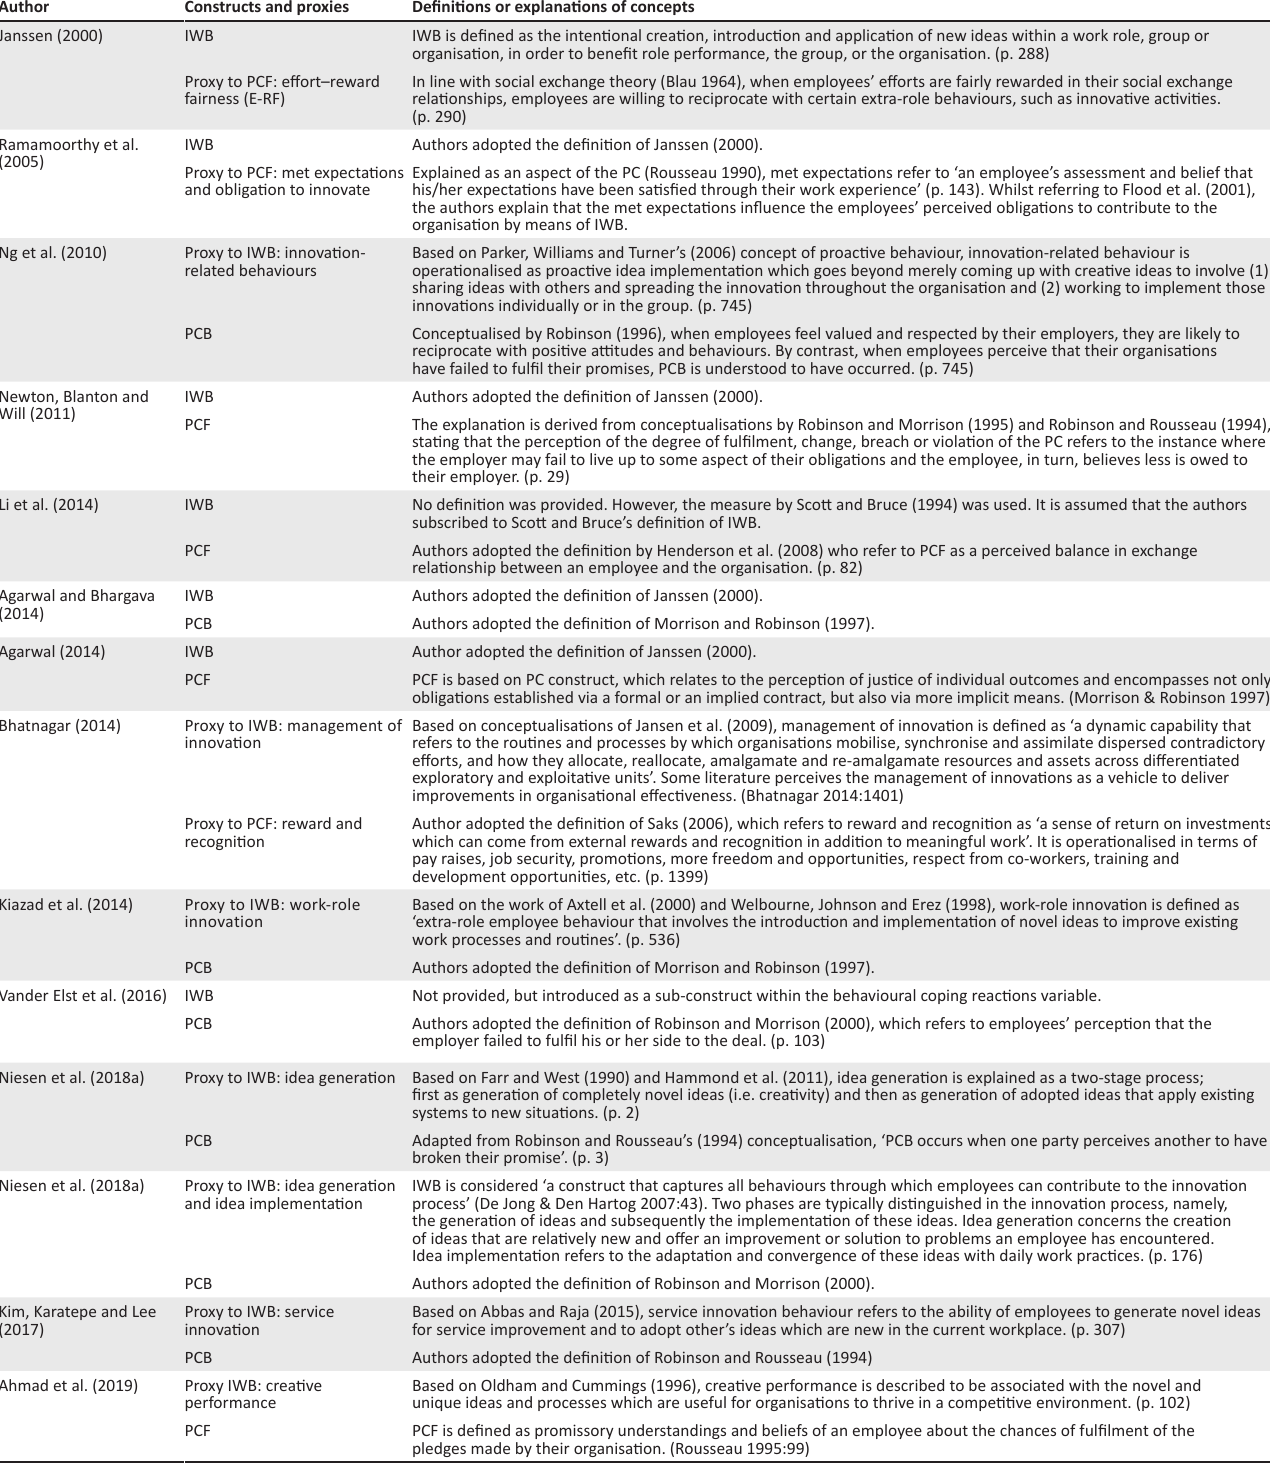
TABLE 1: Definitions of innovative work behaviour and psychological contract breaches and their